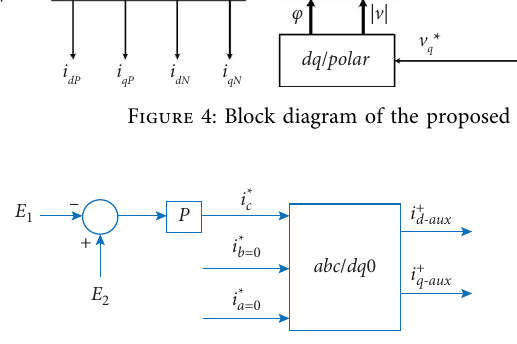
Figure 5: A novel deviation suppression signal for DC-link ca- pacitor voltage.